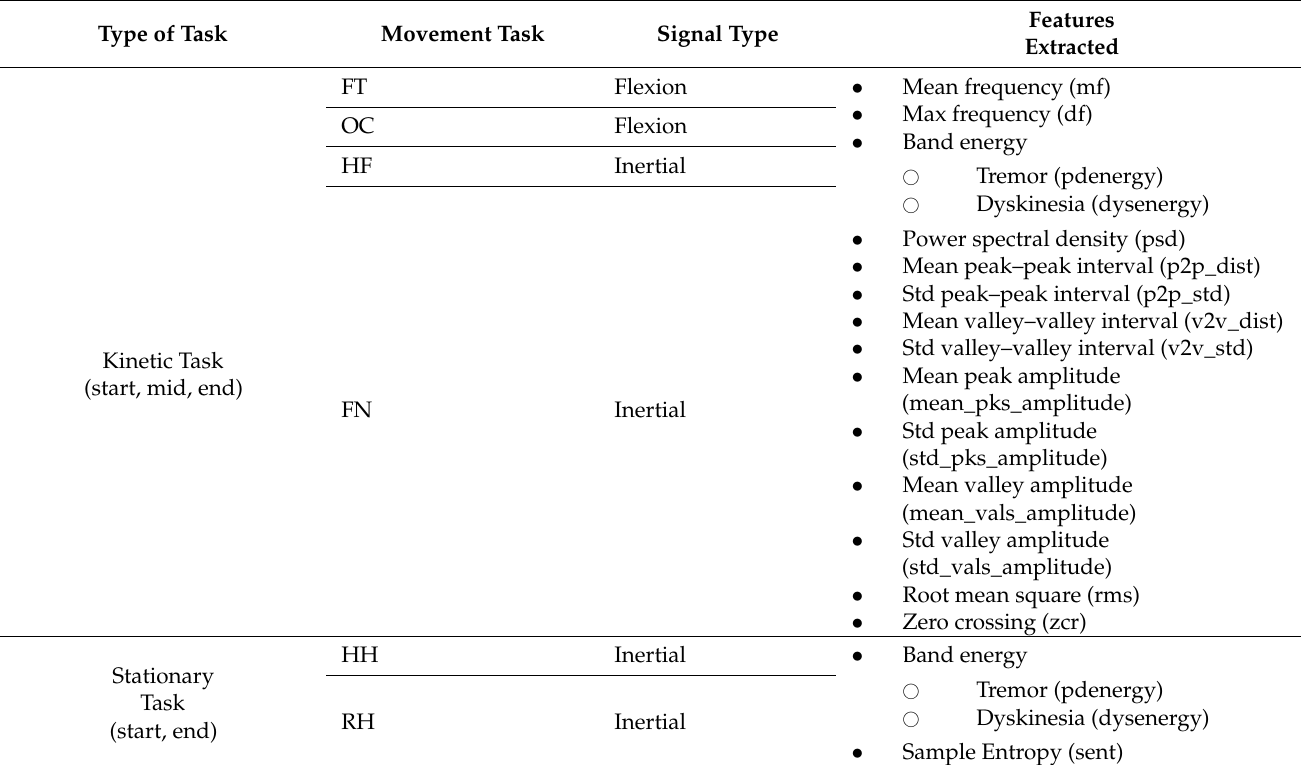
Table A1. Description of features extracted from iTex glove